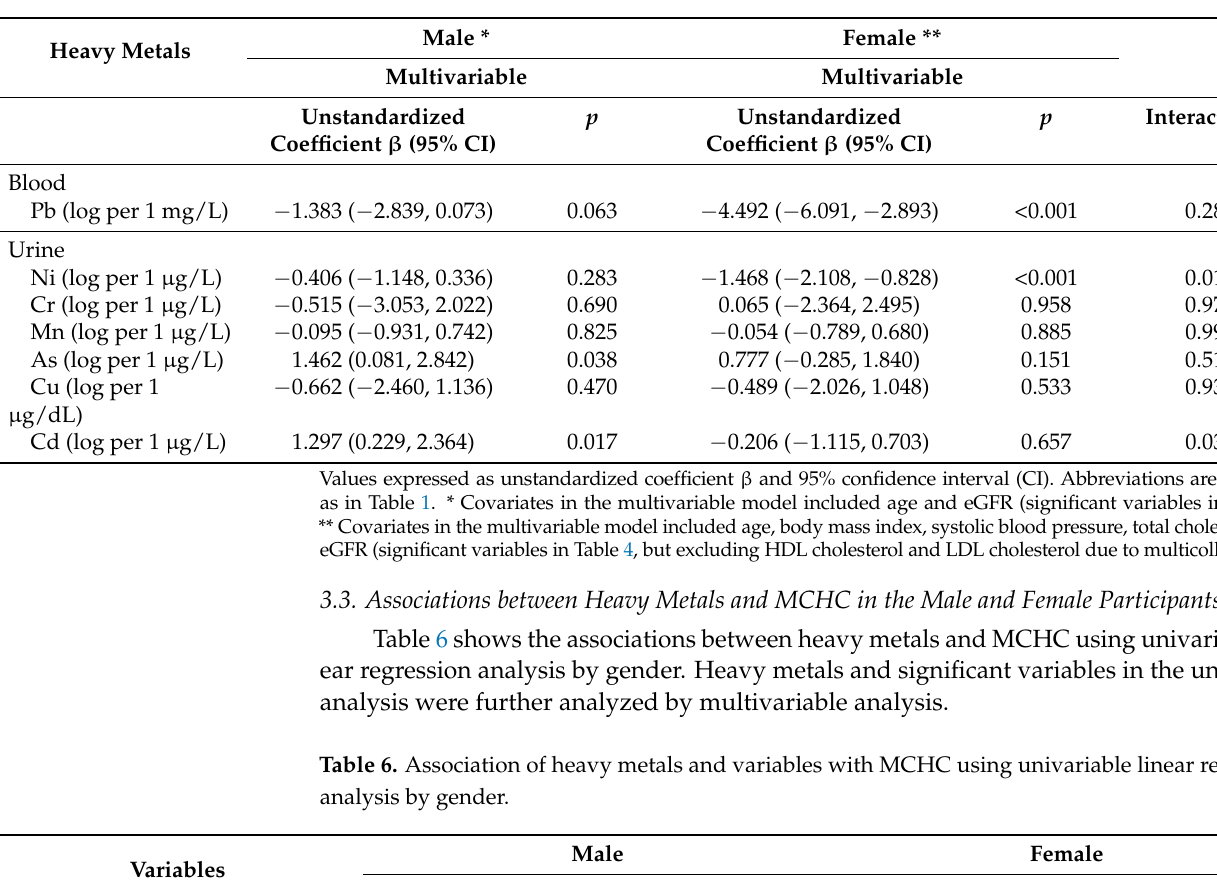
Table 5. Association of heavy metals with MCV using multivariable linear regression analysis by gender.